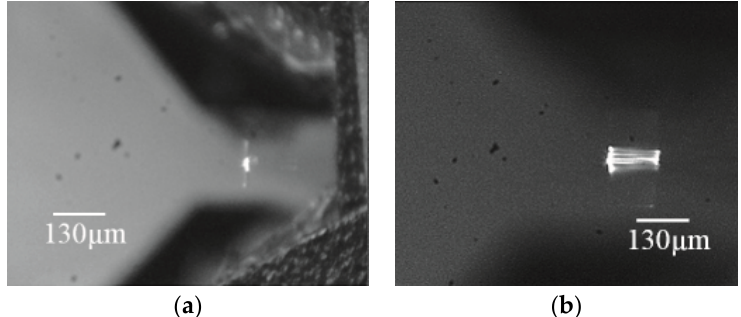
Figure 27. Microscopic images show the vertical displacement driving at ( a ) 0 Hz, ( b ) non-resonating 2D scanning at 201 Hz in vertical and 20 Hz in horizontal direction. (Pictures are taken directly above the scanner so vertical and horizontal directions are switched).